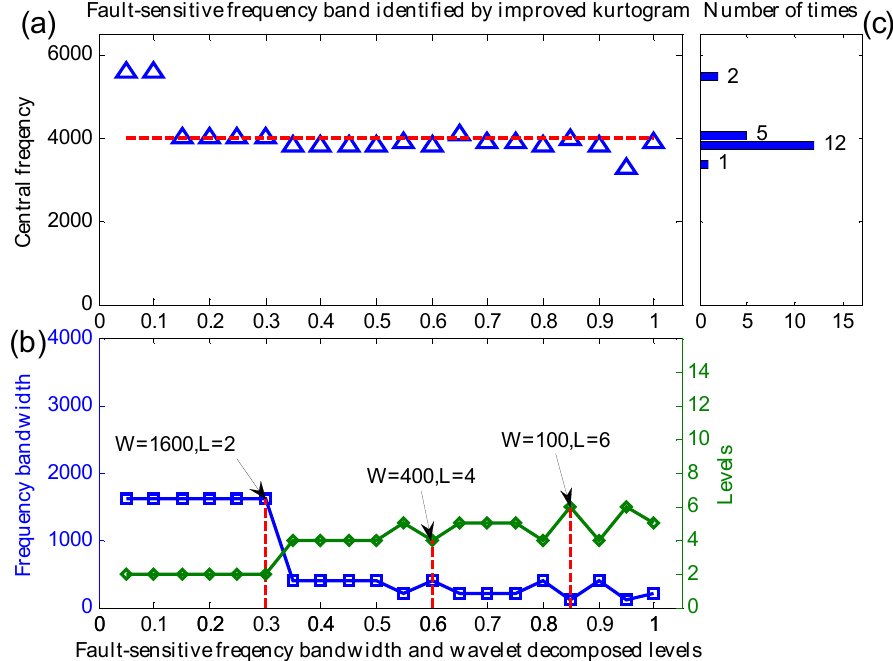
Figure 9. ( a ) The central frequencies; ( b ) the frequency bandwidth and decomposition levels; ( c ) distribution of central frequencies.